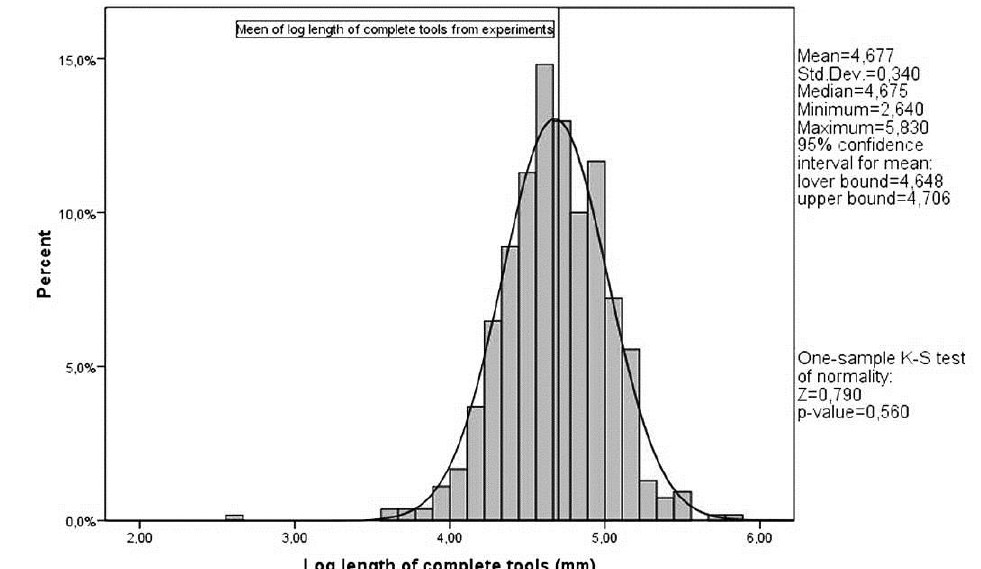
Figure 8. Distribution of length of ancient tools of the Russian Karelian type found in all possible contexts (logarithmic scaling) and results of one-sample Kolmogorov-Smirnov test (K-S test) of normality. Only complete tools without distinctive traces of repair are